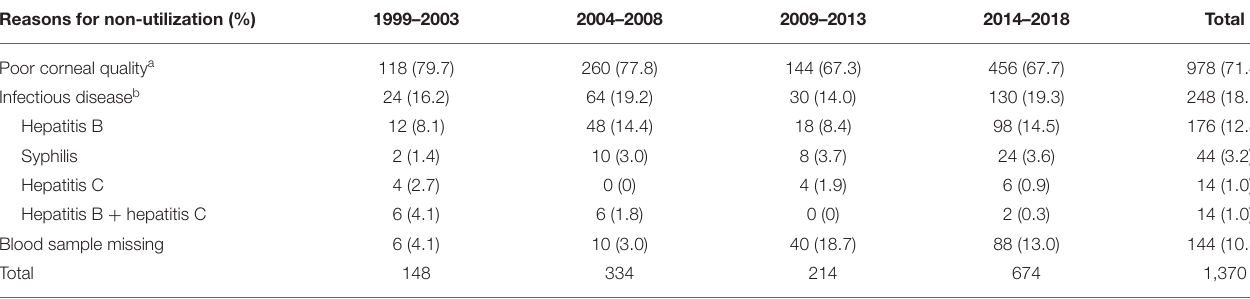
TABLE 1 | Summary of non-utilization of the cornea due to various reasons. Reasons for non-utilization